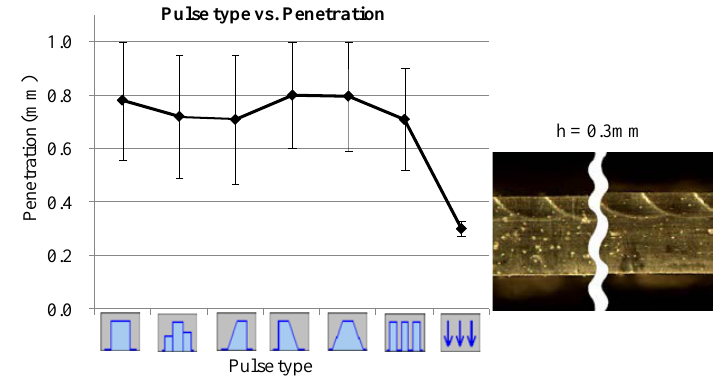
Figure 14. Effects of pulse type on weld penetration.